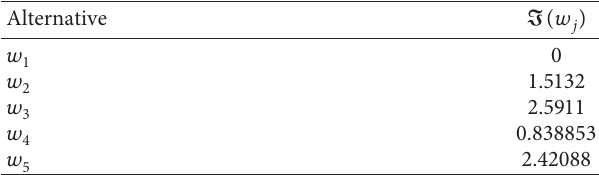
Table 50: Revised closeness index of each alternative.